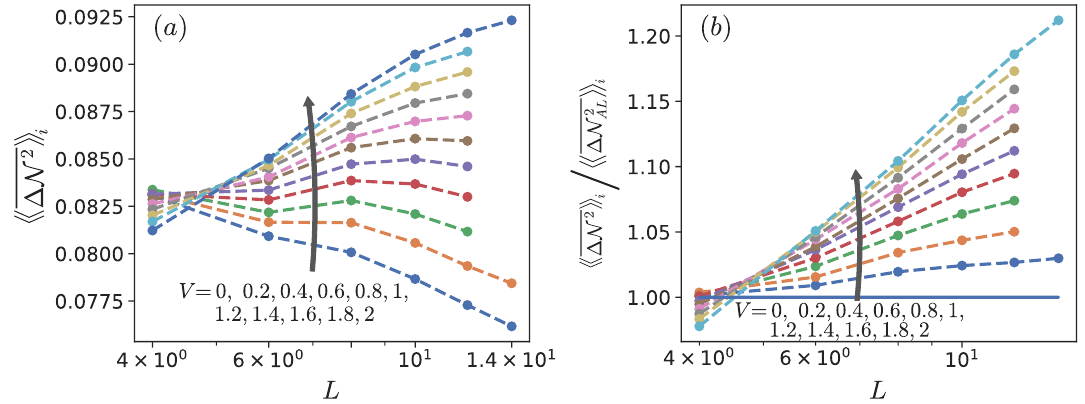
(cid:10)(cid:10) ∆ (cid:11)(cid:11) N 2 for the full microscopic i (cid:10)(cid:10) ∆ (cid:11)(cid:11) N 2 . AL i